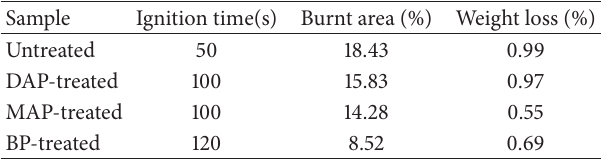
Table 7: Result of the flammability test